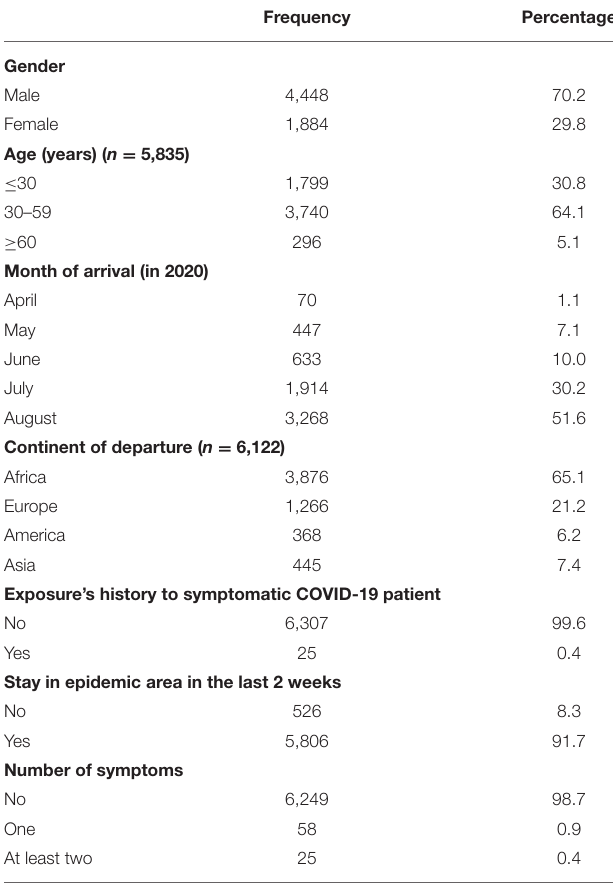
TABLE 1 | Baseline characteristics of